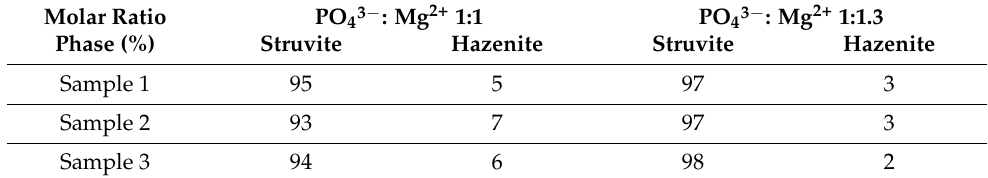
Table 4. Percentages of phase values obtained from precipitates identified using XRD method. Molar